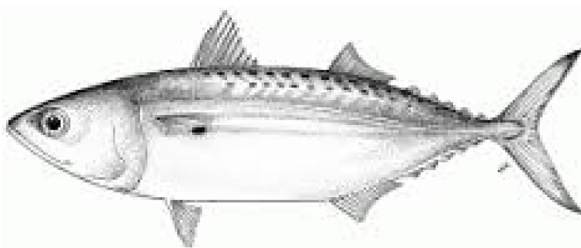
Fig 2. Kembung fish ( Rastrelliger kanagurta